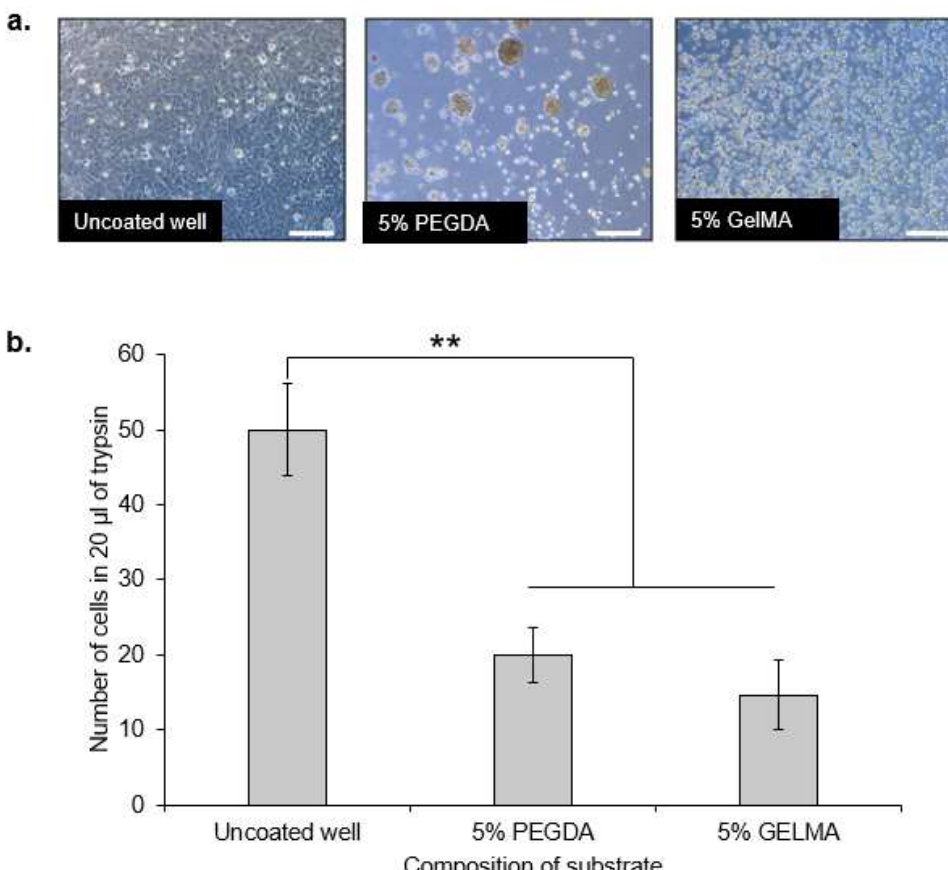
Figure 2. Behavior of HaCaT keratinocytes on PEGDA and GelMA hydrogels ( a ). PEGDA encourages aggregation of HaCaT keratinocytes while GelMA does not encourage aggregation of HaCaT keratinocytes, while the uncoated surface of the petri dish is used as a reference for full attachment and spreading of HaCaT keratinocytes ( b ). HaCaT keratinocytes do not differ in surface adhesiveness towards PEGDA or GelMA substrates and show preferential attachment to the uncoated wells (** p <0.01, as compared to the uncoated well). All scale bars represent 200 μm.